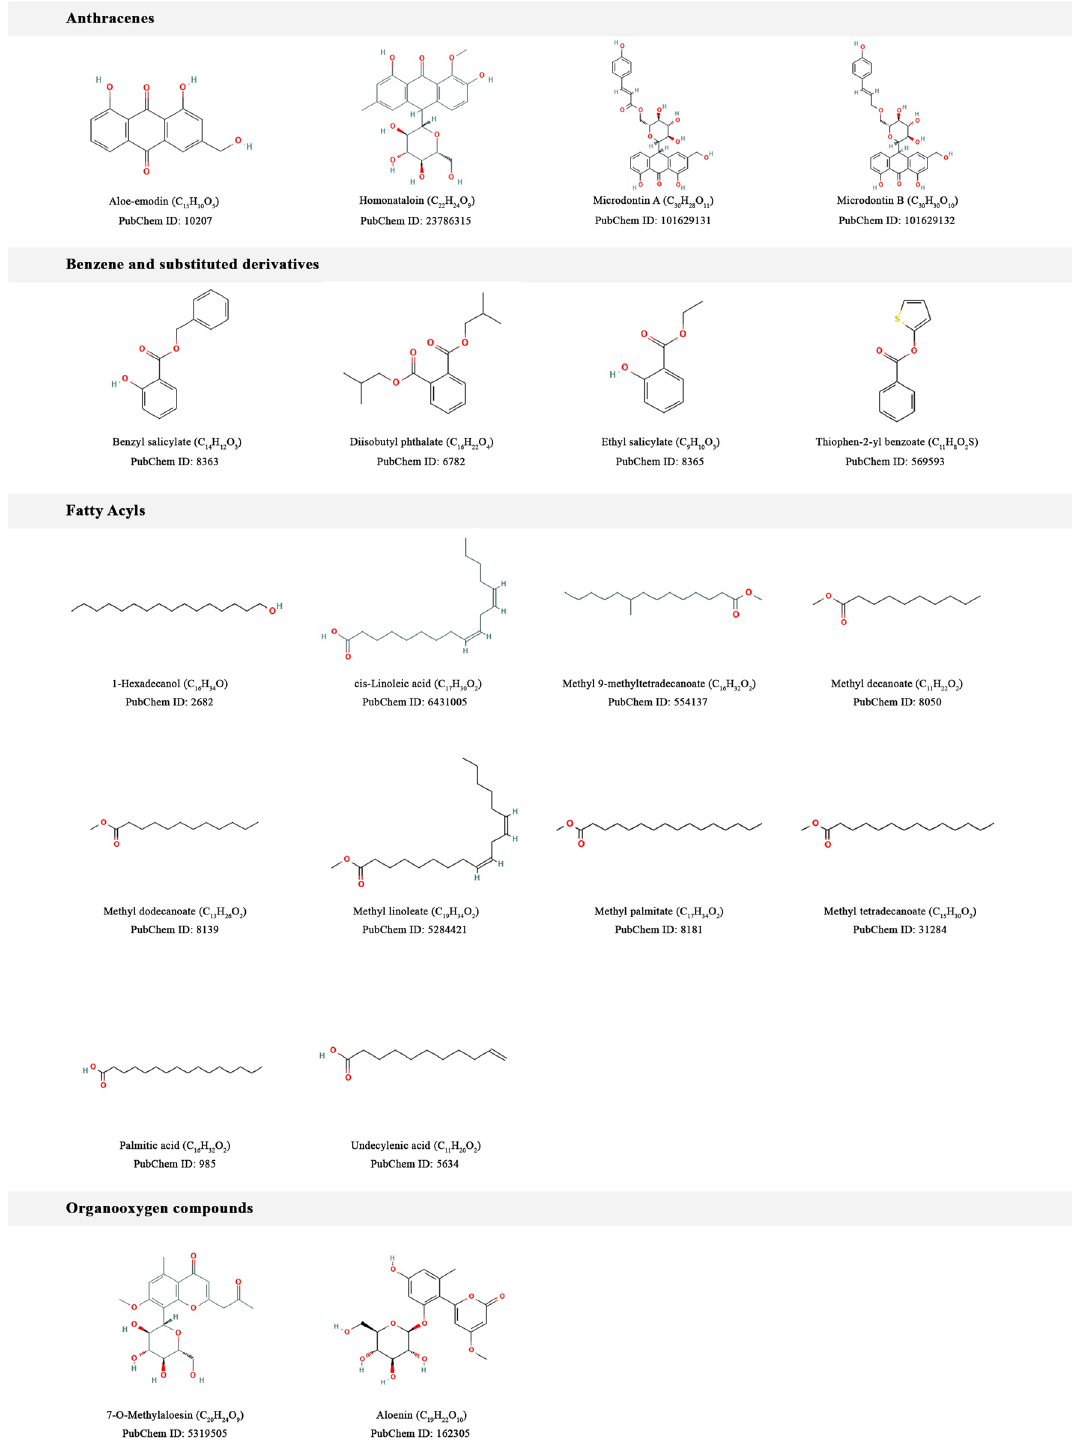
Figure 11. 2D chemical structures and compound classes of phytochemical constituents of Ethiopian indigenous aloes whose human targets were successfully predicted using pharmacophore